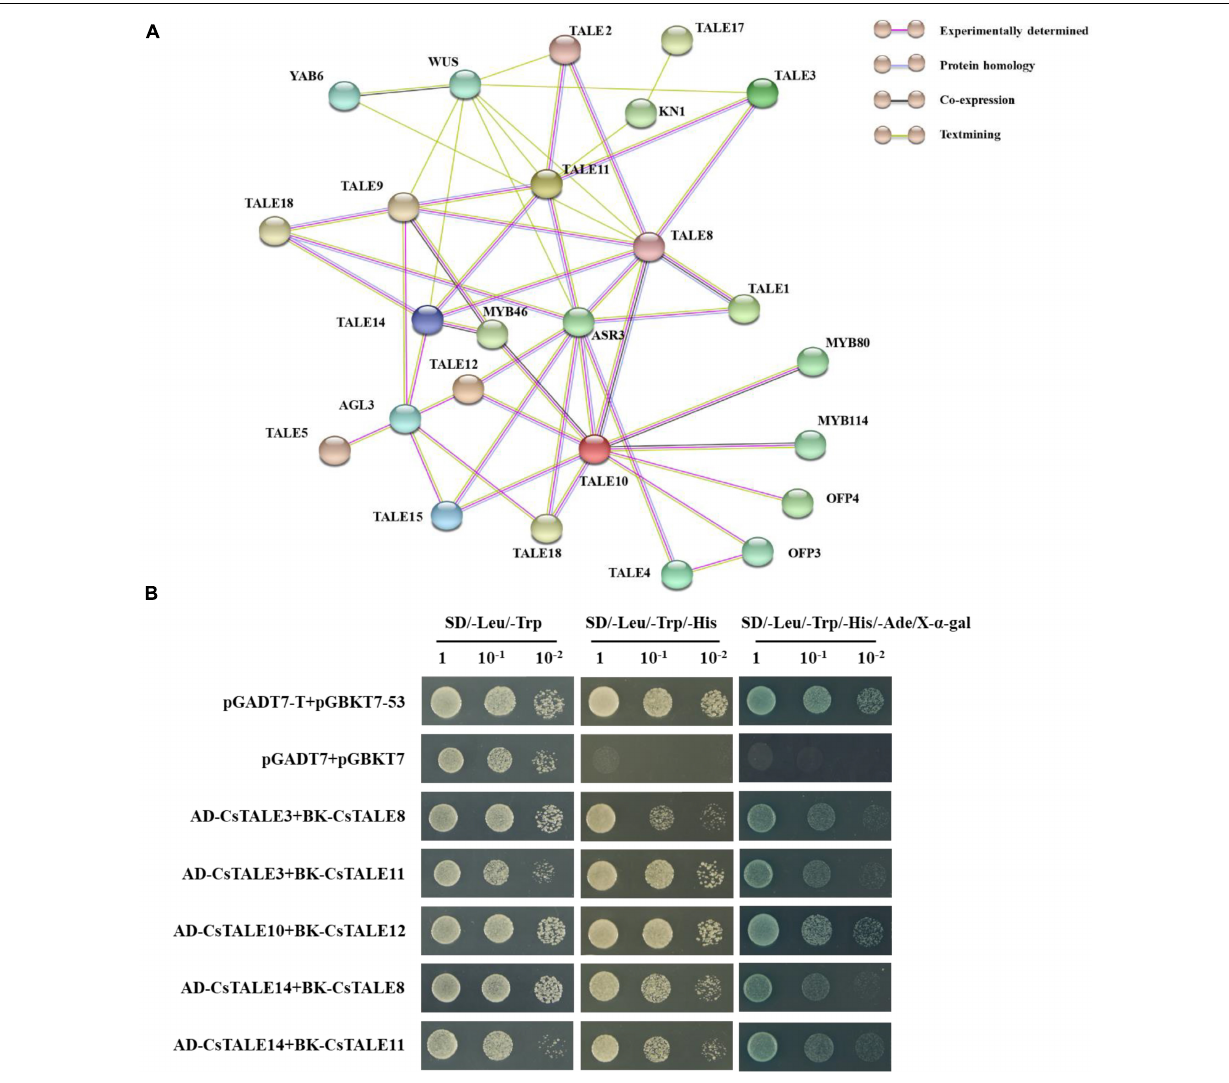
FIGURE 8 | Interaction network and protein interaction of CsTALEs. (A) Interaction network of TALE. Nodes represent proteins, and lines represent protein interaction pairs. Line colors represent different types evidence of protein interaction pairs. (B) Yeast two-hybrid assays. The co-transformed yeast cells were diluted to different concentrations (1, 10 − 1 , 10 − 2 ) and cultured in SD/–Leu/Trp, SD/–Leu/Trp/His and SD/–Leu/Trp/His/Ade + X- α -gal